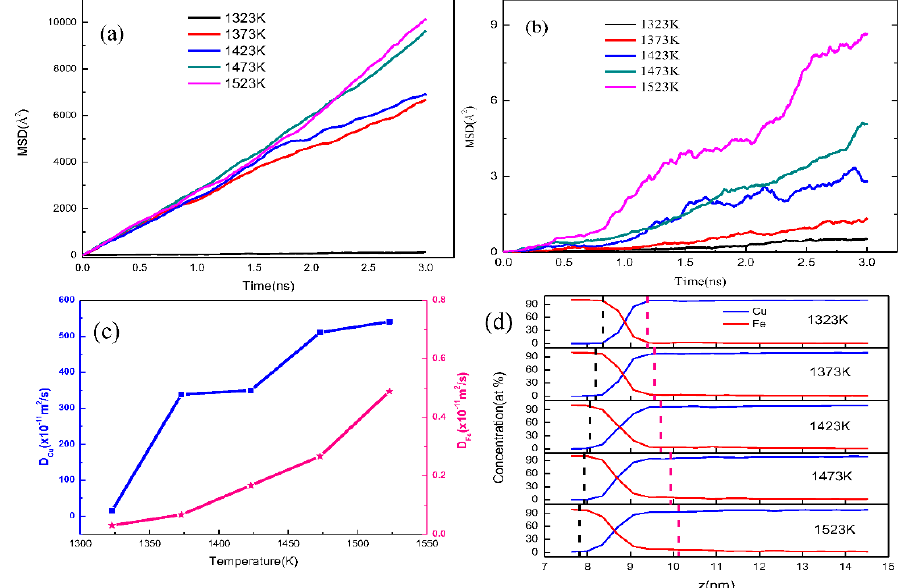
Figure 5. The diffusion behavior of atoms and the diffusion distance of Fe (110)/Cu (110) interface under different temperatures. ( a ) MSD curves of Cu atoms under different temperatures; ( b ) MSD curves of Fe atoms under different temperatures; ( c ) diffusion coefficient of Fe and Cu atoms; ( d ) atomic concentration of Fe and Cu atoms.